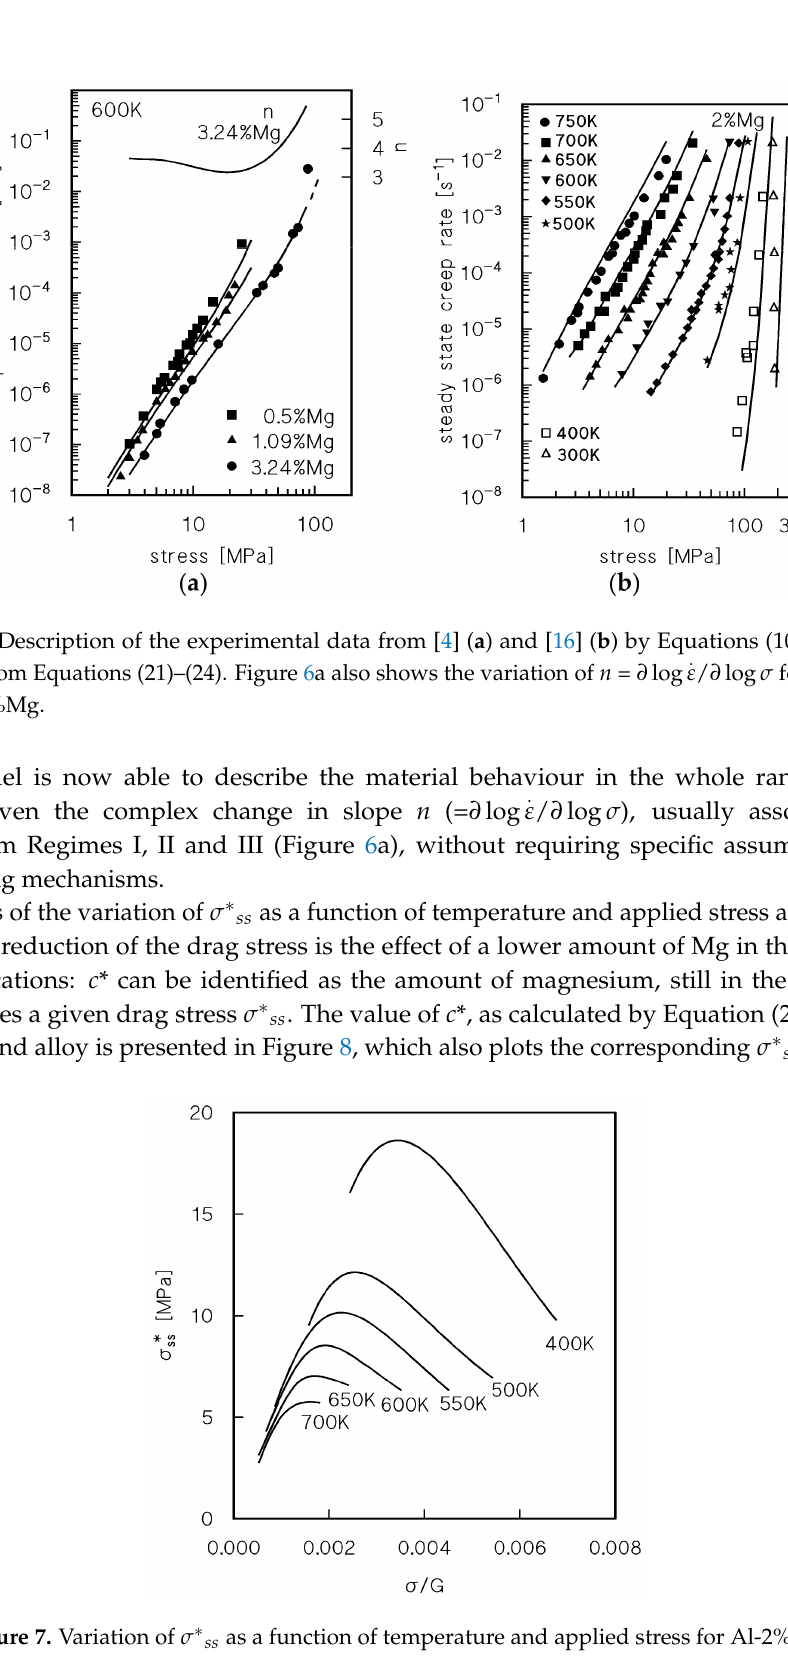
Figure 7. Variation of σ ∗ ss as a function of temperature and applied stress for